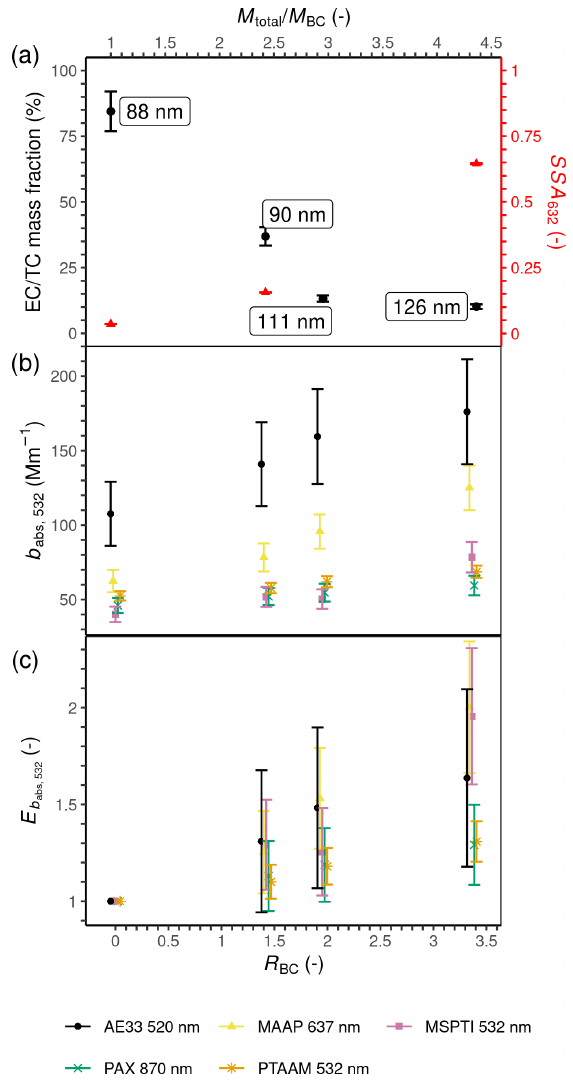
Figure 3. Measurements obtained with setup 0.1. (a) EC / TC mass fraction as a function of total mass to BC mass ratio and R BC . The total mass to BC mass ratio and R BC are based on TEOM measure- ments. The single-scattering albedo (SSA) at 637nm, calculated from b abs measured by the MAAP and the scattering coefficient measured by the nephelometer, is shown on the secondary y axis. The sample geometric mean diameter is shown as a label on each data point. (b) Absorption coefficient ( b abs ) as a function of total mass to BC mass ratio and R BC . All b abs values have been con- verted to a wavelength of 532nm using the absorption Ångström ex- ponents determined from the b abs values of the PTAAM. The legend below Fig. 3c indicates the wavelengths at which the measurements were performed. All b abs values have also been scaled by the num- ber concentration. The values are listed in Table S2. (c) Absorption enhancement factor E b (532nm) as a function of total mass to abs BC mass ratio and R BC . The data points in panels (b) and (c) have been slightly shifted along the x axis to improve the readability of the graph. The error bars designate measurement uncertainties for k = 1 (68% confidence interval). The uncertainty ( k = 1) in R BC is estimated to be about 5% (not